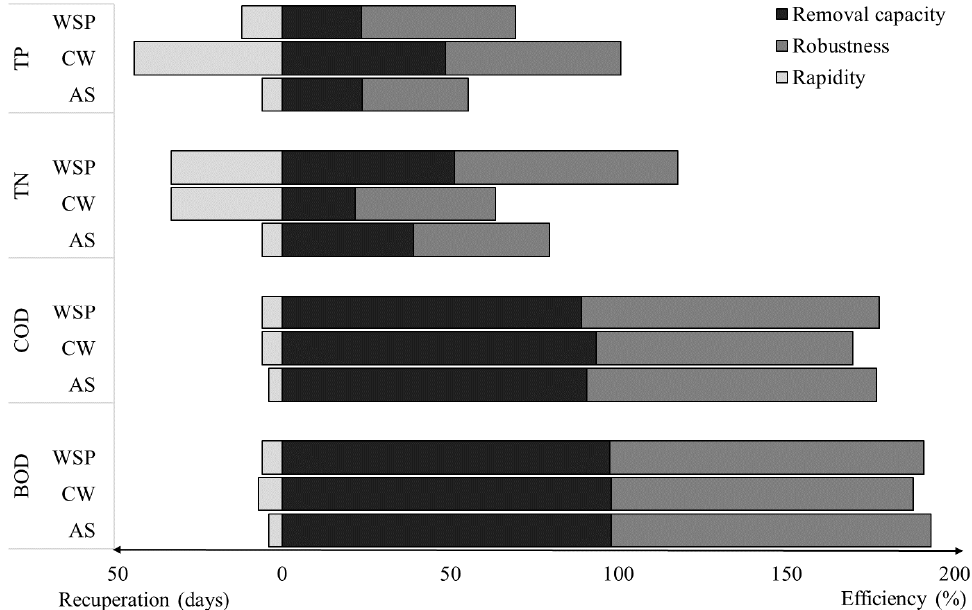
Figure 7. Overview of the removal and resilience capacities of the three systems. Their removal capacity (black) and robustness (dark grey) were calculated as averaged removal efficiencies during the first and second phases of the peak scenario. Rapidity (light grey) was the number of days needed for the systems to recover. When this period exceeded 31 days of the scenario, their rapidity was extrapolated from the linear regression of the decreasing pollutant concentrations in the third phase.